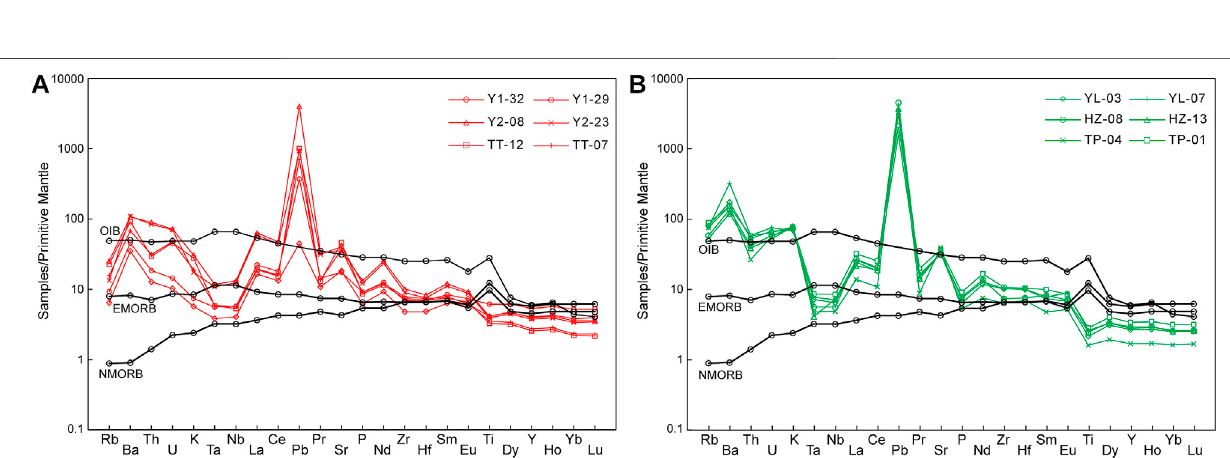
Frontiers in Earth Science |